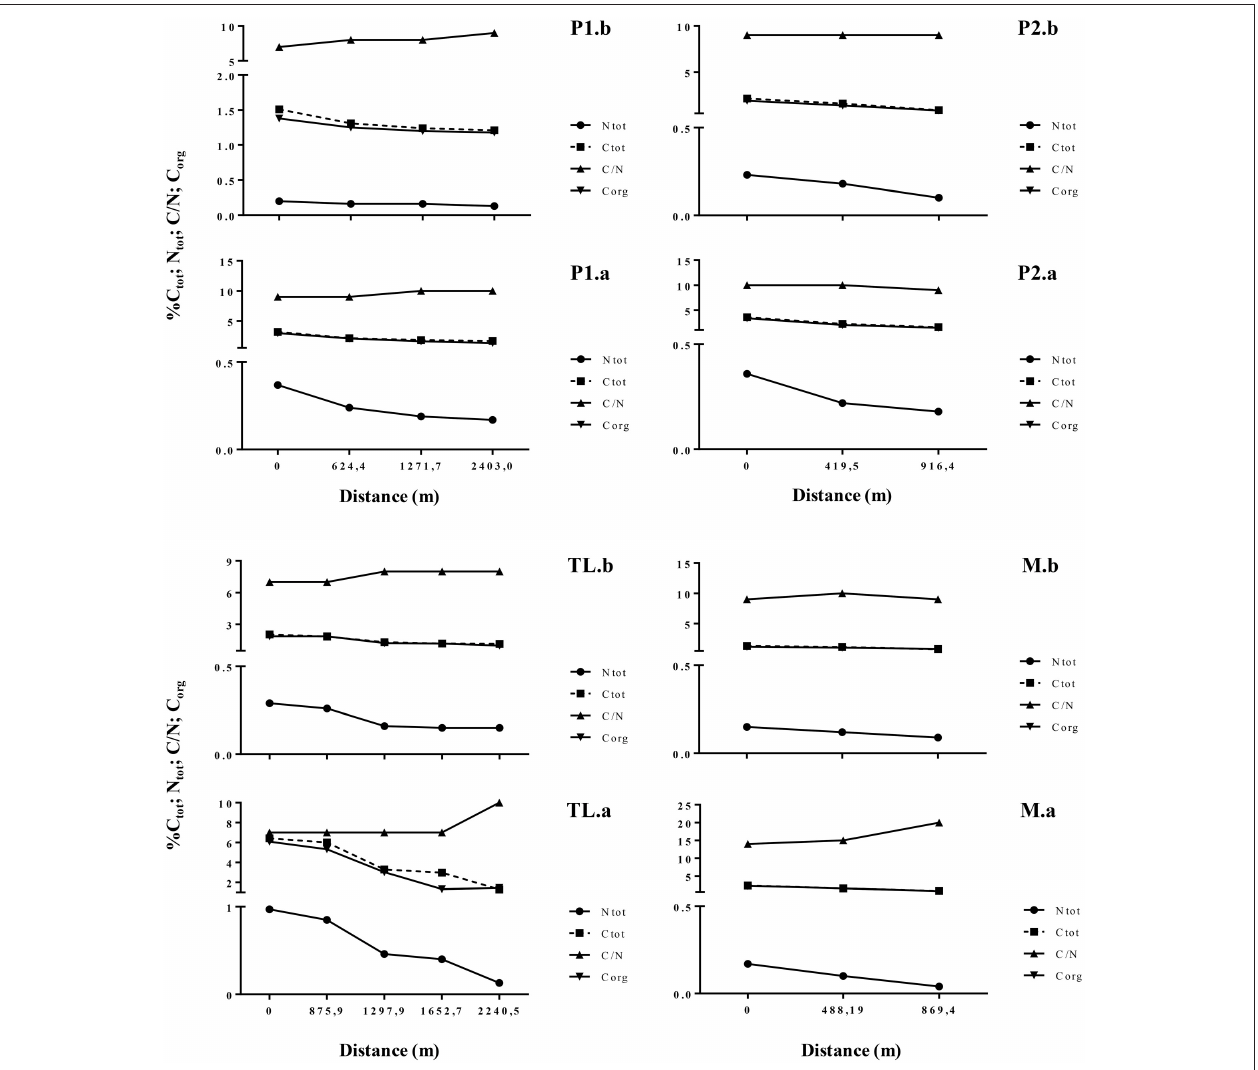
FIGURE 2 | Change of C tot ; N tot percentage; C/N and C org ratio from terrestrial to sea. TL, Tallo estuary; M, Maros estuary; P1 and P2, Pangkep estuary. a, Transition Season (April 2013); b, Dry Season (June